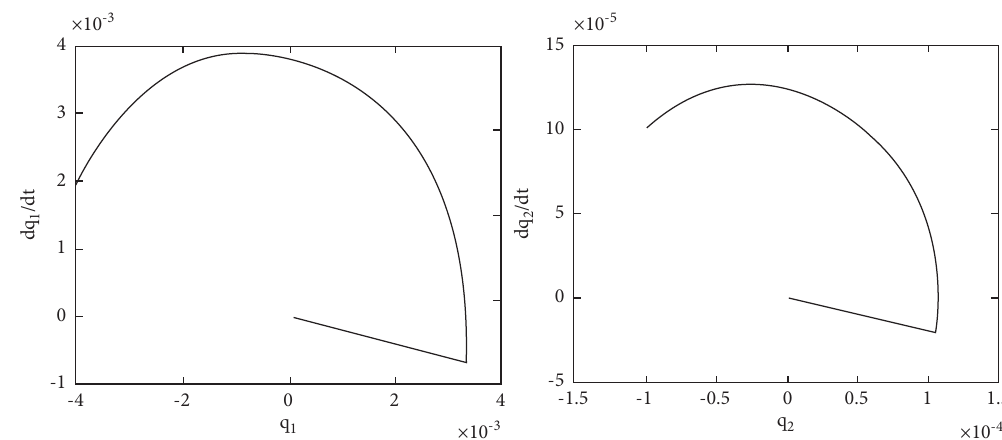
Figure 4: The response of the phase trajectory of the first two modes of the beam after variable structure control.